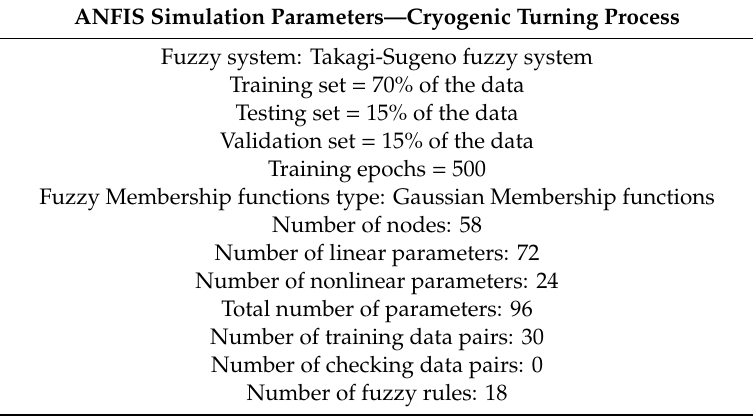
Table 8. ANFIS simulation parameters—cryogenic turning process.